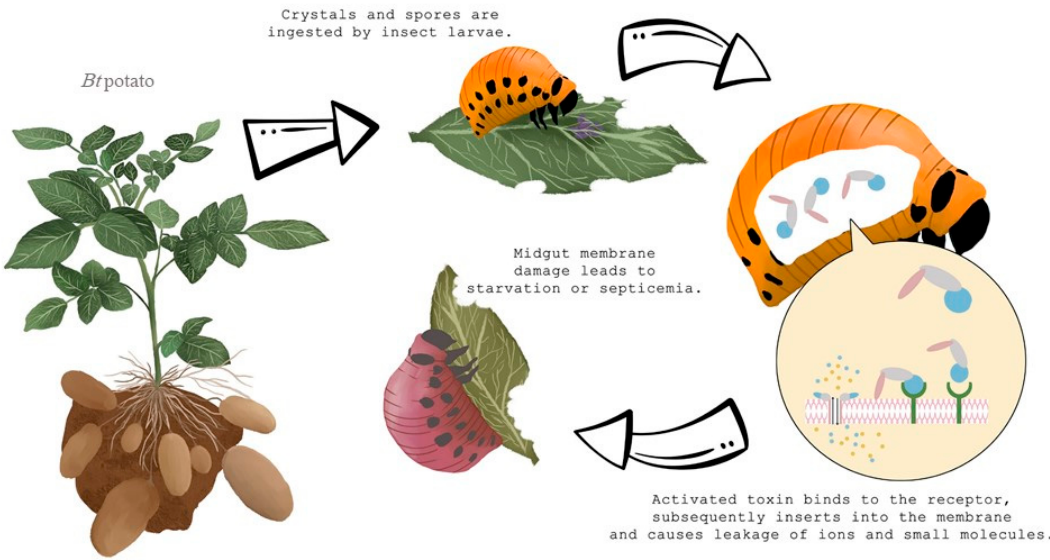
Figure 3. How Bacillus thuringiensis ( Bt) toxin a ff ects Colorado potato beetle